Question: What type of chart is this?
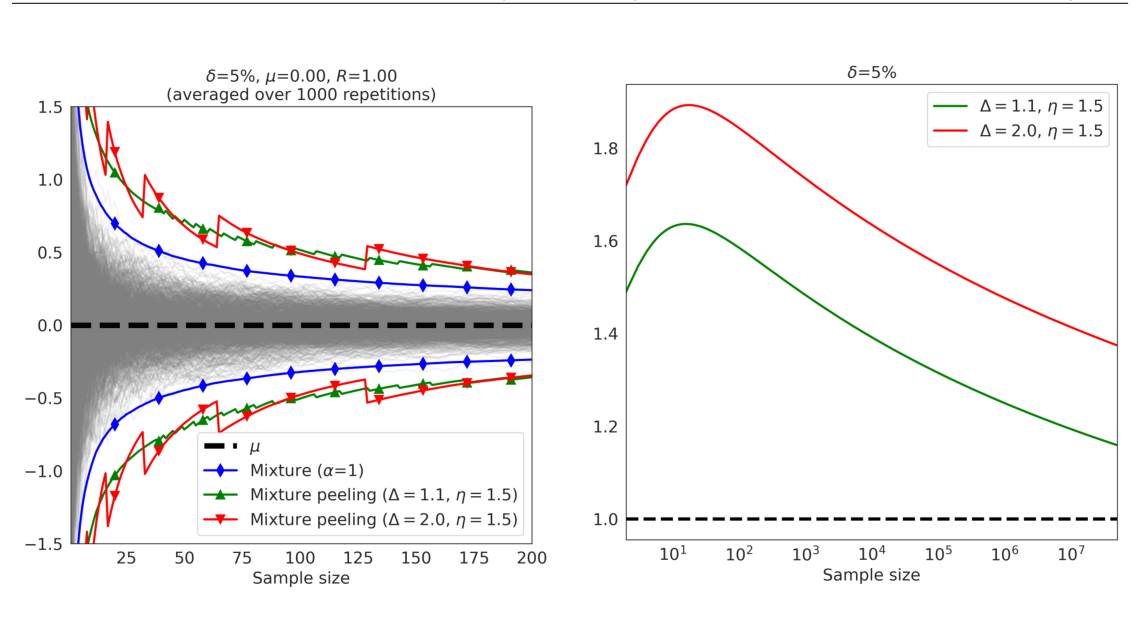
Answer: line